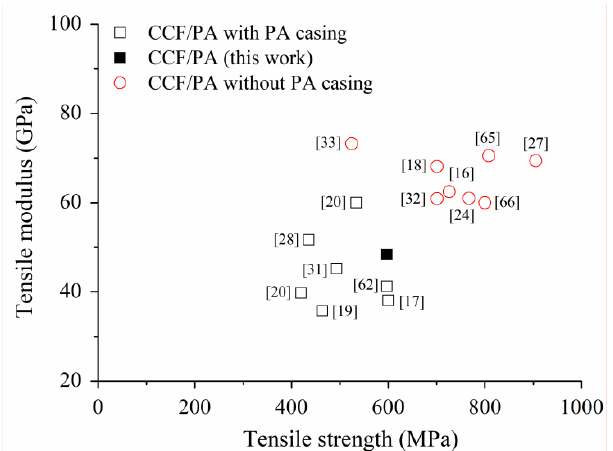
Figure 9. Comparison of the tensile properties of longitudinal CCF/PA laminates produced by the FFF process using MarkForged printers. The expression “PA casing” refers to the contour and outer layers of neat PA.